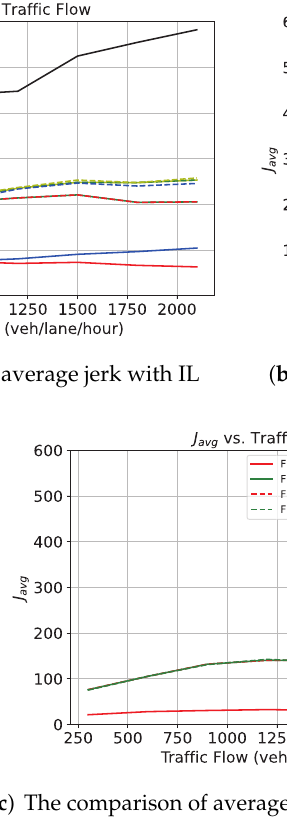
Figure 6. The comparison of average jerk of J avg .